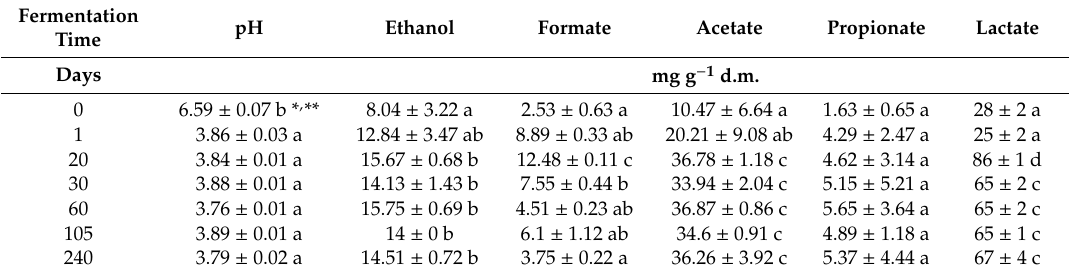
Table 2. pH, short chain fatty acids, and ethanol evolution during TP1 and TP2 fermentation. Fermentation pH Ethanol Formate Acetate Propionate Lactate Time